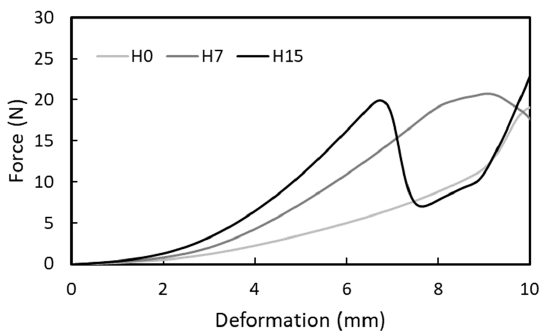
Figure 3. Examples of compression curves of food gel (BC20) on artificial tongues.